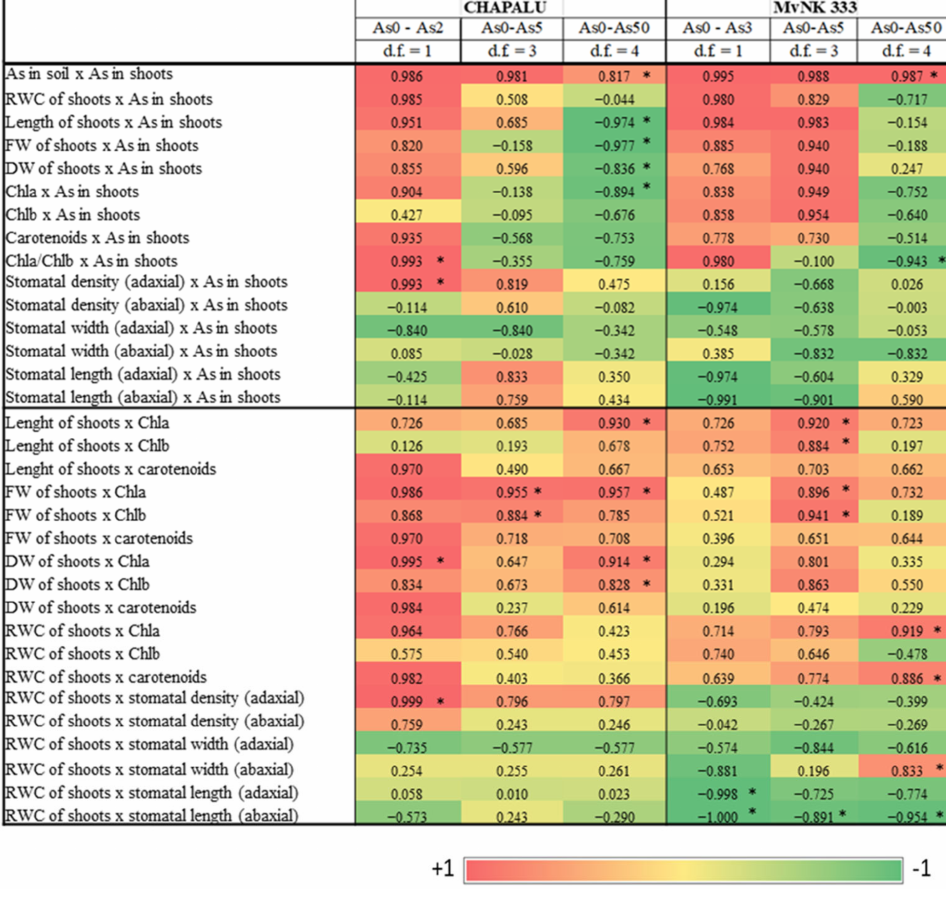
Figure 7. Correlation analysis in a heat map for three level of As dose. *—significant correlation at p < 0.05; d.f.—degrees of